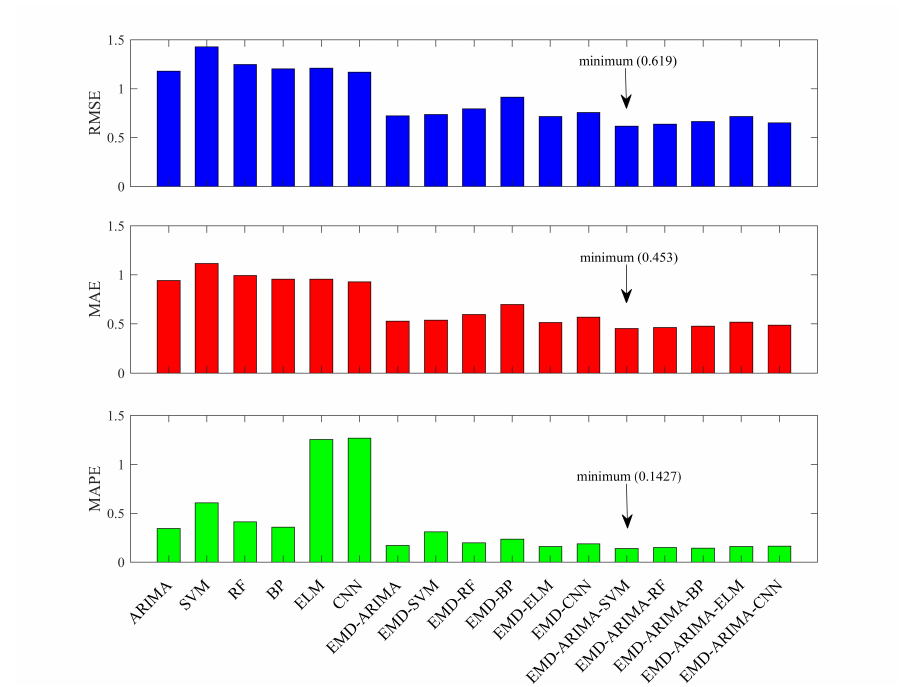
Figure 12. Wind speed prediction comparisons for the 1 h data at the GS site.